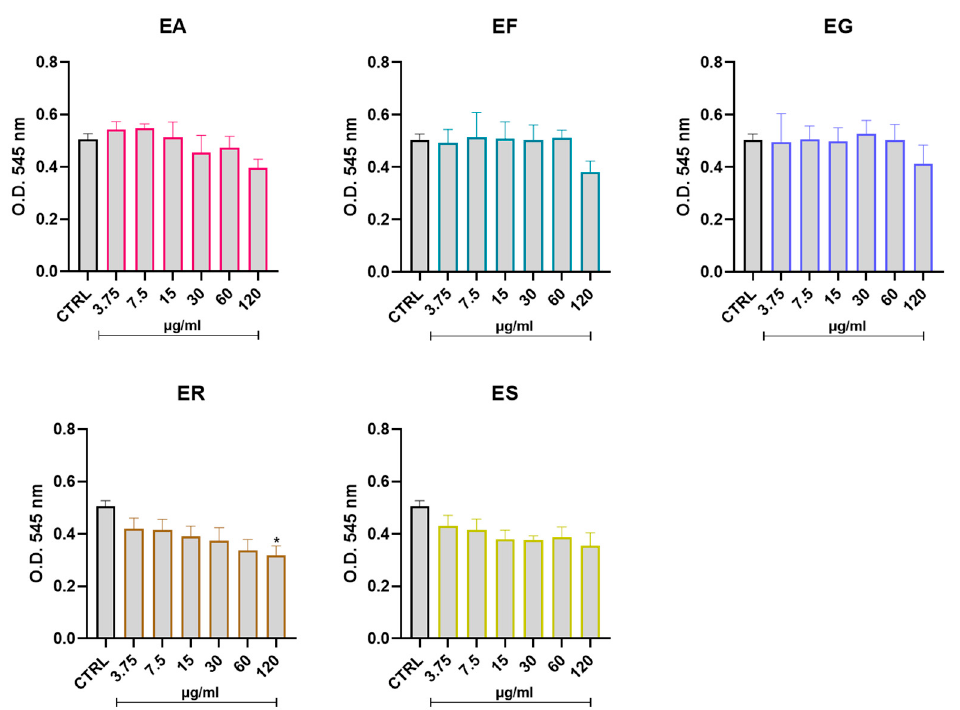
Figure 5. Effect of the EOs on cell vitality. The J774A.1 macrophages were treated with increasing concentrations of Eos, and cell viability was examined after 24 h by the MTT assay. Values are expressed as mean ± SEM from three independent experiments. * p < 0.05 indicates the significant effect of the EOs compared to control cells (EA = E. alba , EG = E. eugenioides, EF = E. fasciculosa , ER = E. robusta and ES = E. stoatei